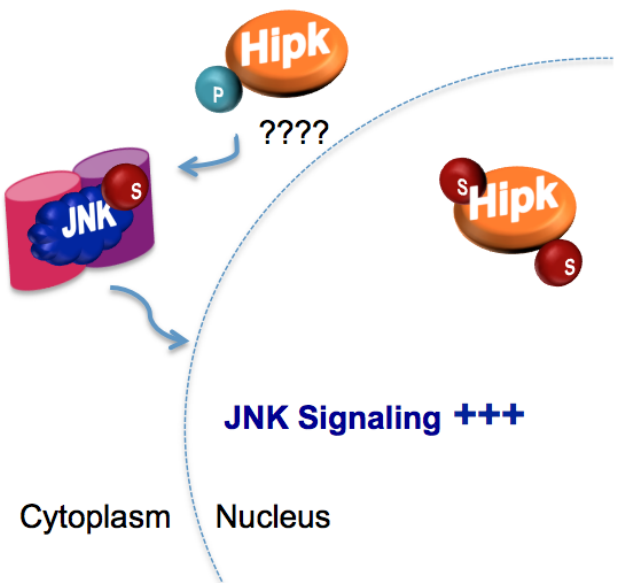
Figure 3. Homeodomain interacting protein kinase (Hipk) SUMOylation may down-regulate c-Jun N-terminal kinase (JNK) signaling. Phosphorylation of JNK in the cytoplasm by Hipk may stimulate JNK pathway activity. SUMOylation of Hipk may interfere with JNK signaling by sequestering Hipk in the